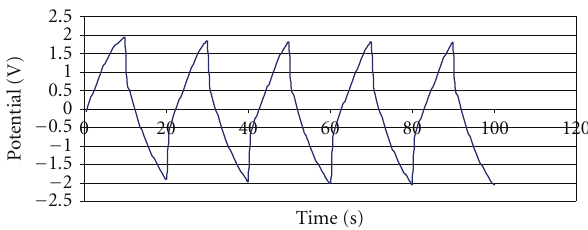
Figure 3: Charge-discharge testing of EDLC CWF-GF/F capacitor at constant current steps of − 5 mA and +5 mA; each carbon electrode has an area of 1 cm 2 and mass of 20mg.